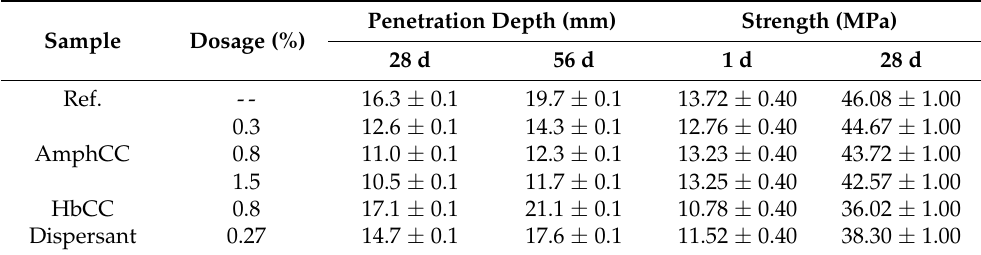
Table 4. Penetration depth of chloride and strength results of the mortar samples.